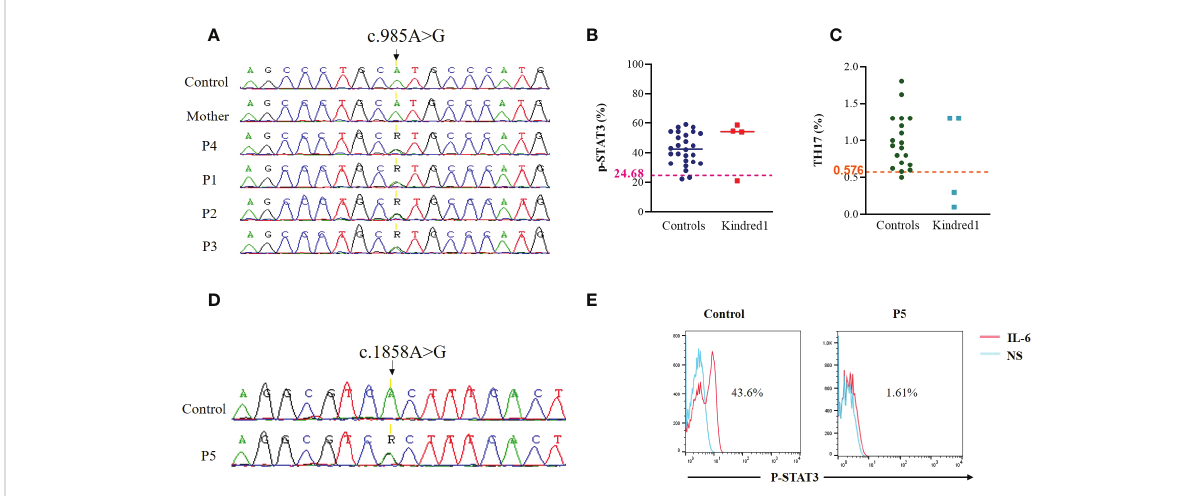
FIGURE 2 Genetic and functional assessment in STAT3 de fi cient patients (A) Genomic DNA sequence analysis in family K1 showing STAT3 heterozygous variant (c.985A>G) in patients compared to WT/WT healthy control (B) Flow cytometric analyses of STAT3 phosphorylation (Tyr705) in PBMCs stimulated with IL-6 (20 ng/mL) for 20 minutes in family K1. Threshold values were determined according to the 5th percentile (95% con fi dence interval) in control groups. Signi fi cant differences between patients and controls were de fi ned as below to the threshold value (C) Percentages of Th17 (CD4 + IL17 + INF g - ) cells in non adherent PBMCs stimulated with PMA ionomycin for 12 hours, as measured by Flow cytometry in patients from family K1 compared to controls. Horizontal bars indicate medians (D) Genomic DNA sequence analysis in P5 showing STAT3 heterozygous variant (c.1858A>G) in P5 compared to WT/WT healthy control (E) Flow cytometric analyses of STAT3 phosphorylation (Tyr705) in EBV transformed cell lines stimulated with IL-6 (20 ng/mL) for 20 minutes in P5.